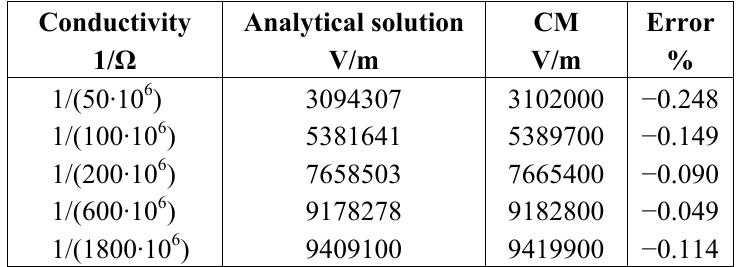
Table 4. Electric field in the steady state at the interface in z = 0.